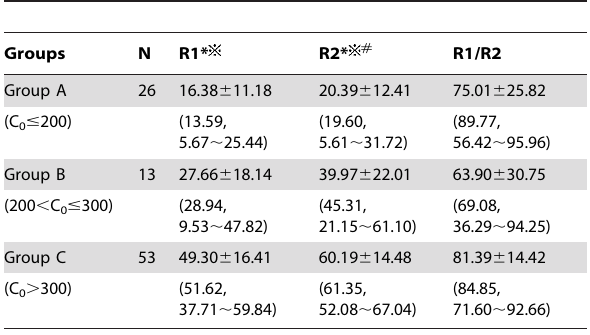
Table 2. Comparison of PQ clearance rate among 3 groups (%).